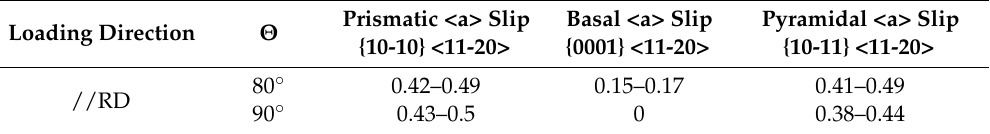
Figure 5. ( a ) Schematic illustration of the dominant texture in the RS-processed sample. Θ : the angle between the c-axis and loading axis; α : the angle between the a-axis and loading axis at the condition where the loading axis is projected onto the basal plane. ( b ) Possible maximum and minimum values of a Schmid factor of three slip systems (prismatic, basal, and pyramidal <a> slips) as a function of the angle Θ . Table 3. Schmid factors calculated for RSA450 sample.